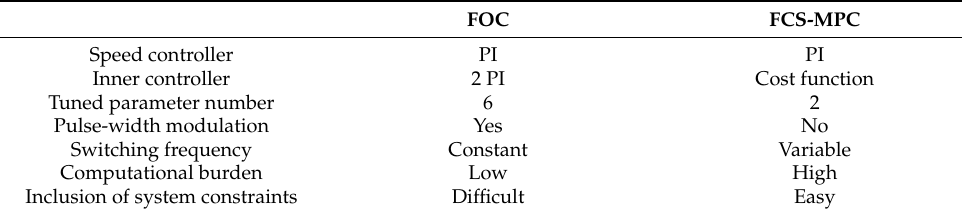
Figure 17. Motor speed response for the sampling frequency of 100 kHz. ( a ) Change in the reference speed; ( b ) change in the load disturbance. Table 8. Comparison of